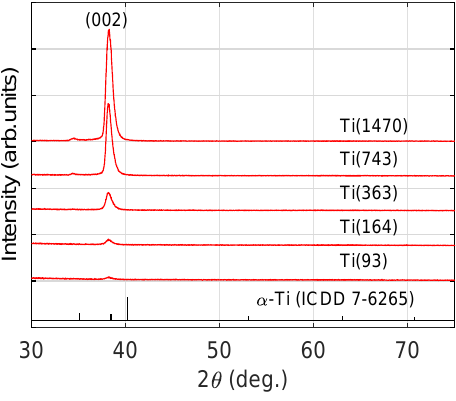
Figure 2. Diffractograms of the Ti